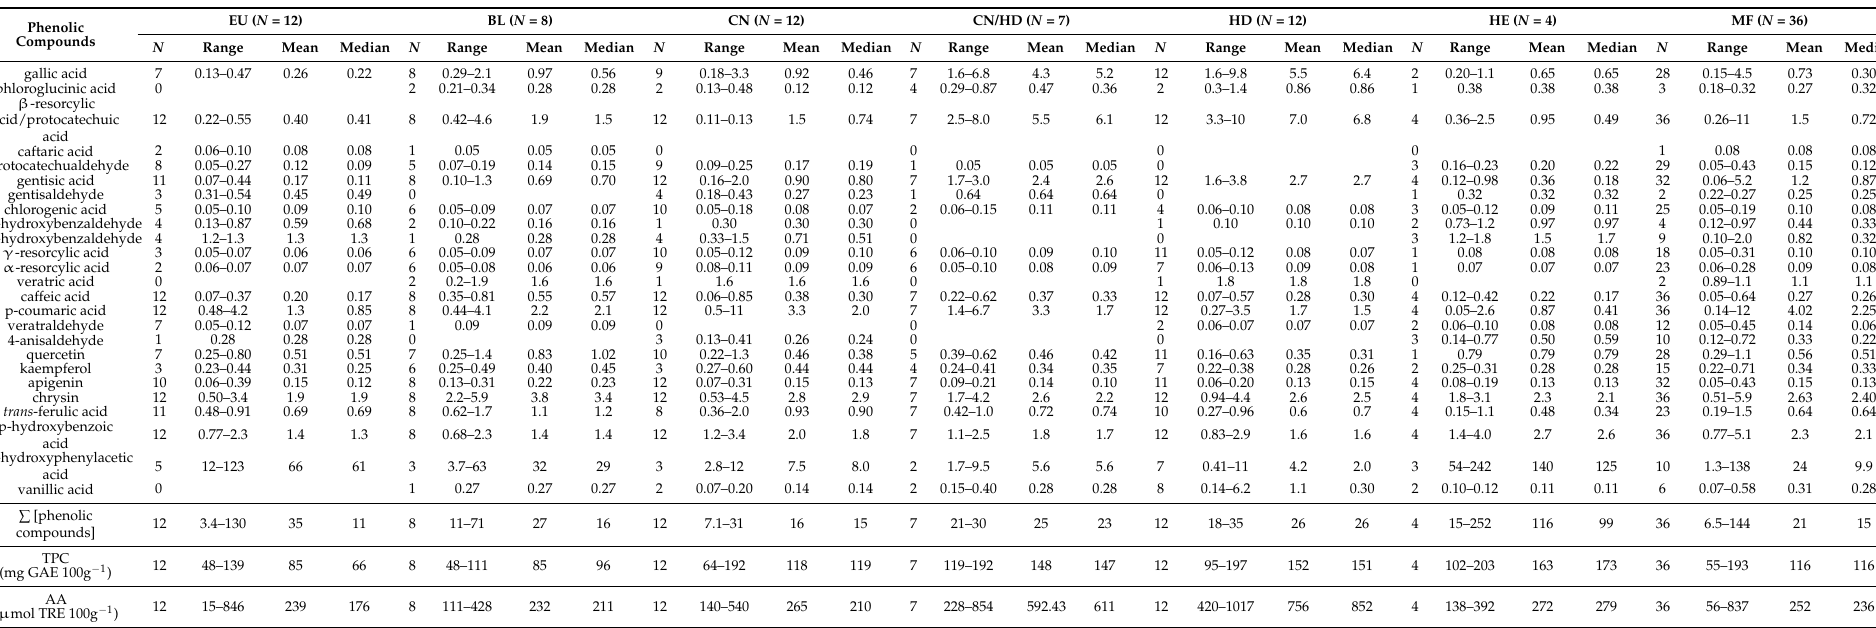
Table 3. Range, mean concentration and median of phenolic compounds ( µ g g − 1 ), TPC (mg GAE 100g − 1 ) and AA ( µ mol TRE 100g − 1 ) for eucalyptus (EU), blackberry (BL), chestnut (CN) and chestnut/honeydew (CN/HD) honeys, honeydew (HD), heather (HE) and multi-floral (MF) honeys. EU( N =12) Phenolic Compounds